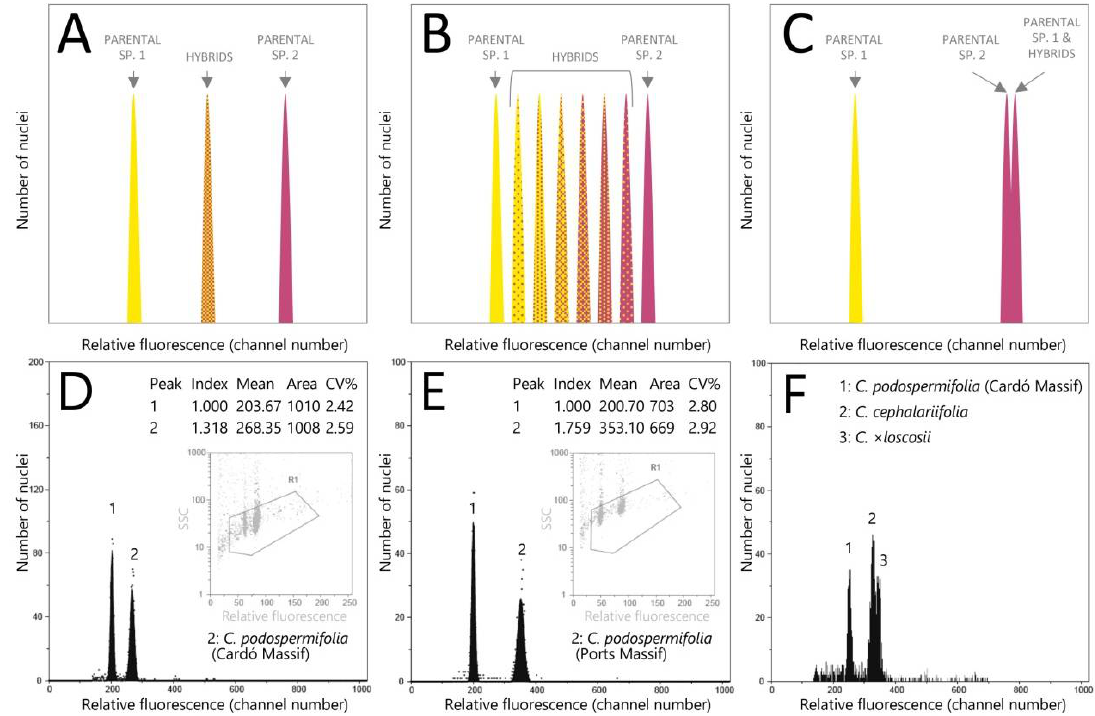
Figure 2. ( A – C ) Schematic flow cytometry outputs when processing together the parental species and their homoploid hybrid. ( A ) Configuration expected in case there is no gene flow between hybrids and parental species, due to, e.g., reproductive barriers or sterility of hybrids. ( B ) Configuration expected in case there is gene flow between hybrids and parental species. ( C ) Observed configuration in the studied populations. ( D , E ) Flow histograms obtained from analysing C. podospermifolia (peak 2) using Petroselinum crispum (4.5 pg/2C, peak 1) as the calibration standard. ( D ) Population from Cardó Massif (OH 621-1). ( E ) Population from Ports Massif (OH 618-4). ( F ) Flow histogram obtained from coprocessing C. podospermifolia (population from Cardó Massif, OH 621-4), C. cephalariifolia (OH 616-2) and C. × loscosii (OH 613-5).